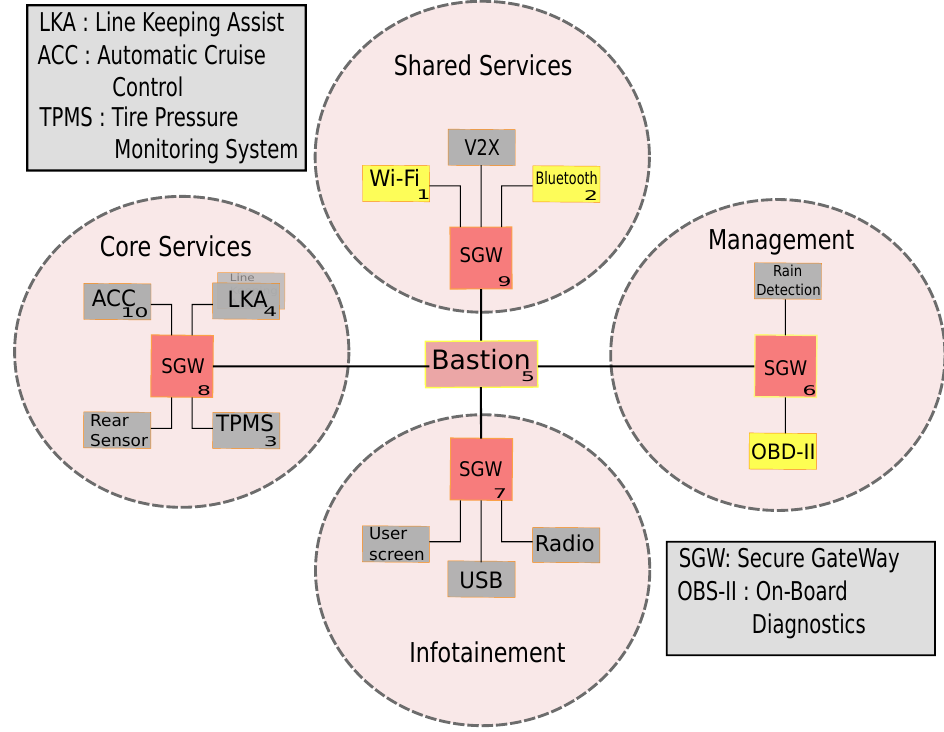
Figure 1. Vehicle architecture